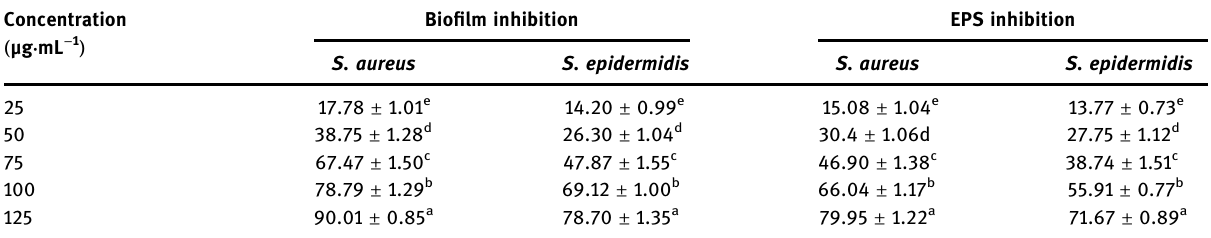
Table 6: Impact of Z. mays - synthesized AgNPs on bio fi lm and EPS inhibition on S. aureus and S. epidermidis Concentration ( μ g · mL − 1 )